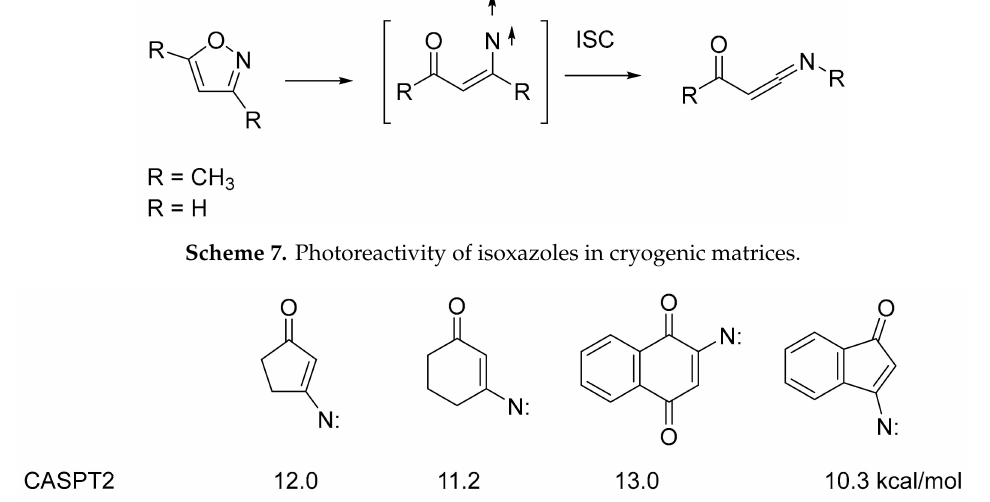
Scheme 8. Calculated singlet–triplet energy gaps of cyclic